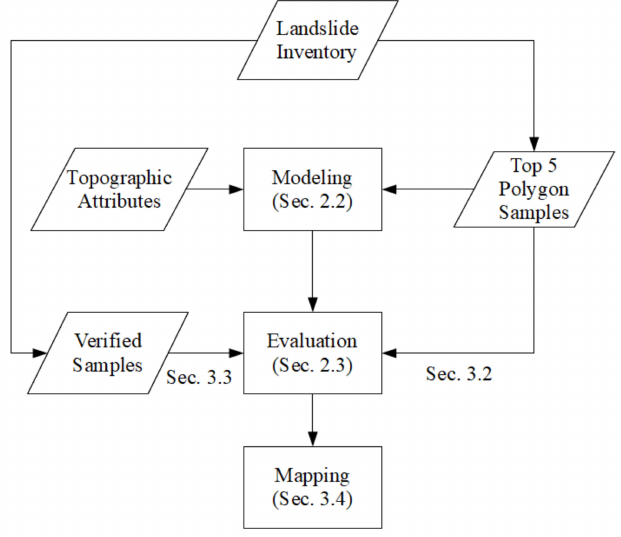
Figure 3. The conceptual procedure used in this study to model and verify the separation between landslide source and runout signatures. Table 1. The training and verification samples extracted from the landslide inventory polygons.